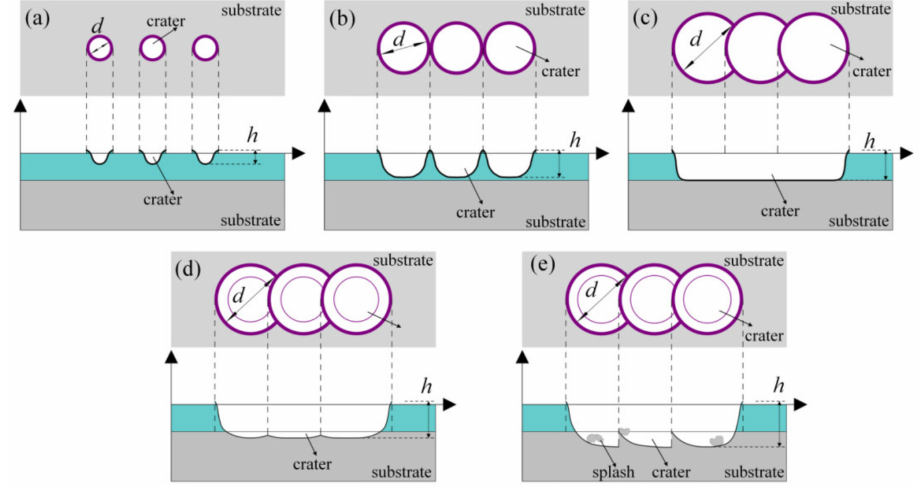
Figure 8. Variation of sample surface roughness with energy density of the water jet-guided